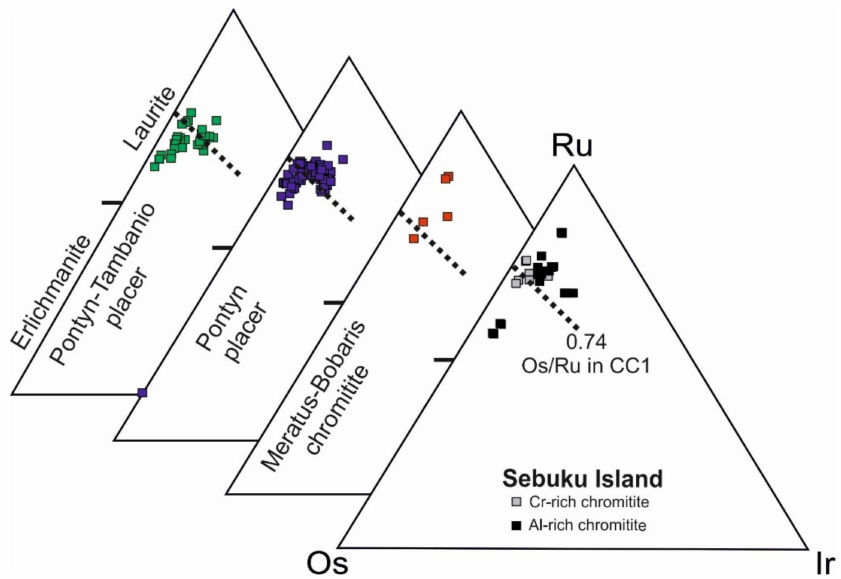
Figure 10. Ru-Os-Ir ternary diagram of the compositions (atomic %) of laurite from Sebuku Island chromitite compared with those from the Meratus–Bobaris chromitite [31] and from the placers of Pontyn and Pontyn–Tambanio [33,34]. Os/Ru ratio (atomic %) calculated from the C1 chondrite [53].